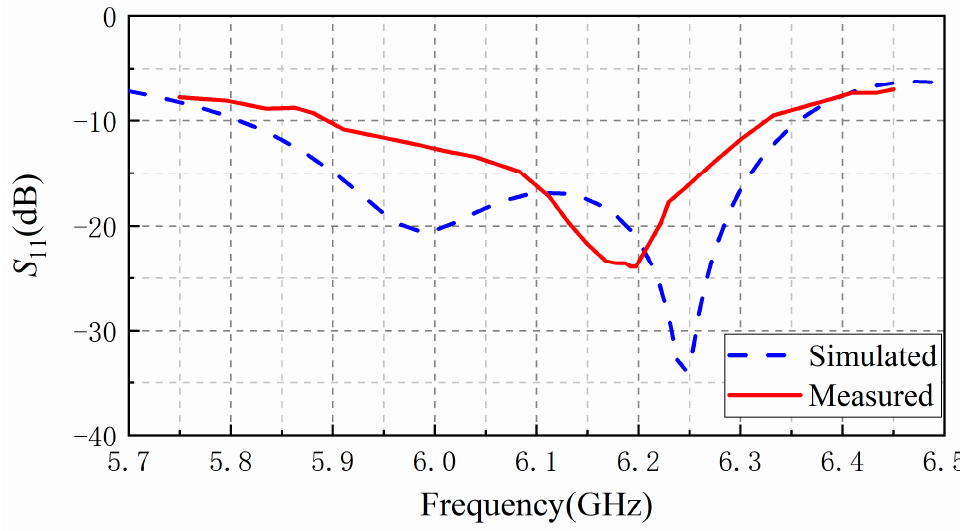
Figure 10. Measured and simulated reflection coe ffi cient ( S 11 ) results of the proposed